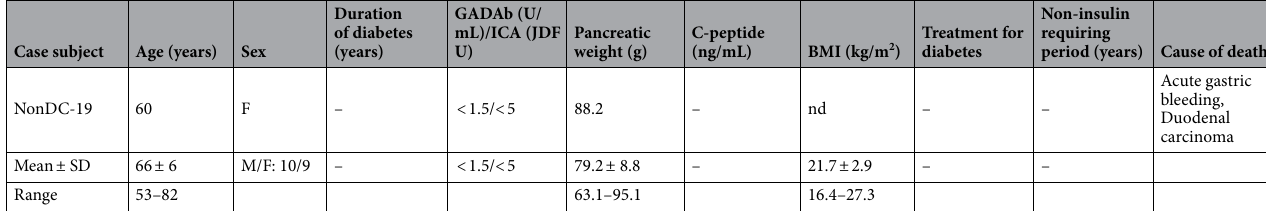
Table 1. Clinical characteristics of the subjects with slowly progressive type 1 diabetes (SPIDDM) and non- diabetic controls (non-DC). *The beta cell is completely abolished case. a Positive for IA-2Ab. b 24-h urine C-peptide (normal 16–120 µg/day). c Biopsied sample. nd not detected, na not